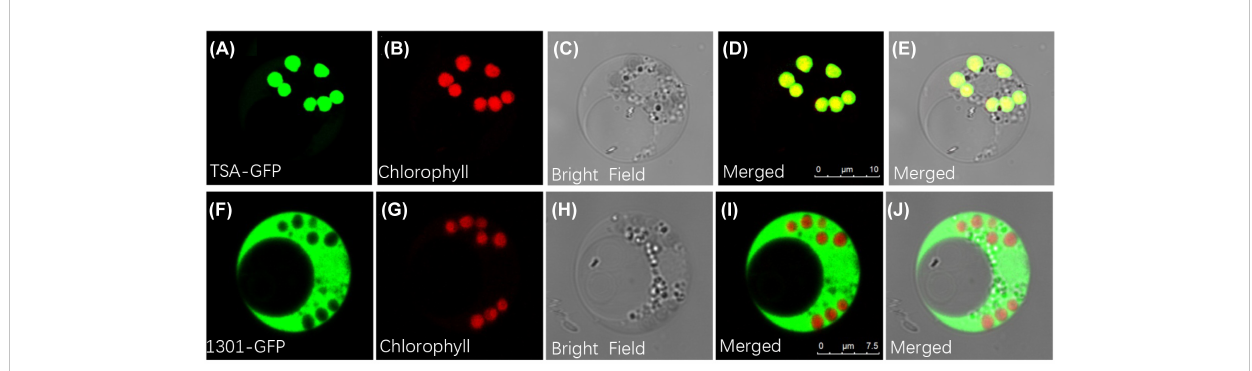
FIGURE 4 Subcellular localization of BcTSA-GFP transiently expressed in rice protoplast cells. (A, F) GFP fl uorescence; (B, G) Red chlorophyll auto fl uorescence in chloroplasts; (C, H) Optical fi elds; (D, I) The merged signal of (A, B) or (F, G) ; (E, J) The merged signal under bright fi